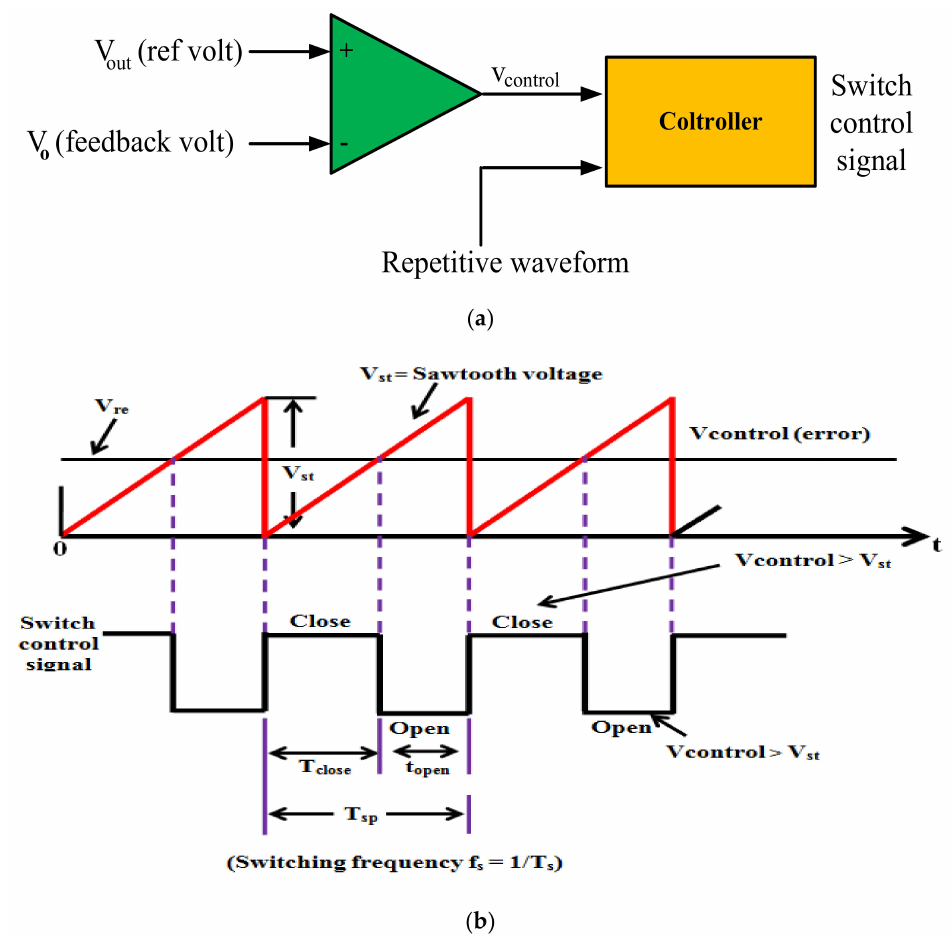
Figure 3. Pulse-width modulator ( a ) block diagram; ( b ) comparator